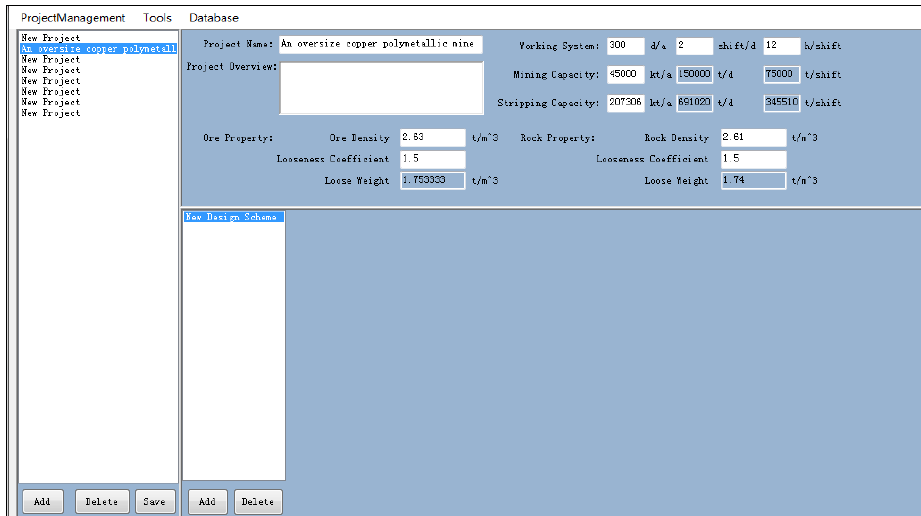
Figure 5. Software management interface.